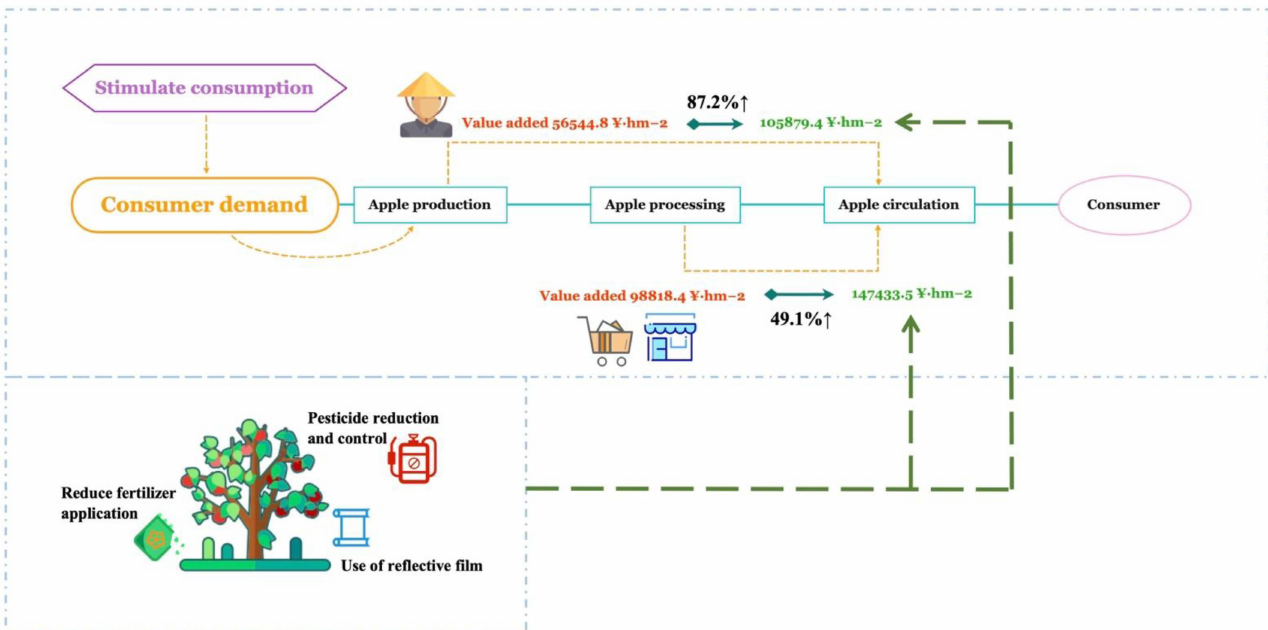
Figure 6. Economic benefits of the apple supply chain and the effect of HYHE horticultural practices on economic